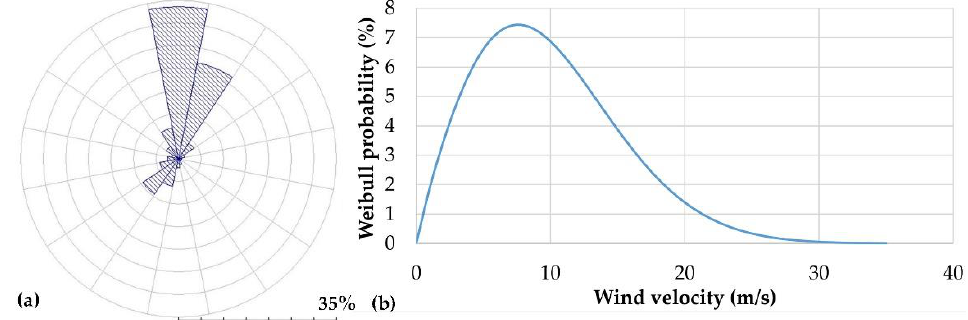
Figure 7. ( a ) Wind rose and ( b ) Weibull probability density distribution based on the executed wind potential measurements .